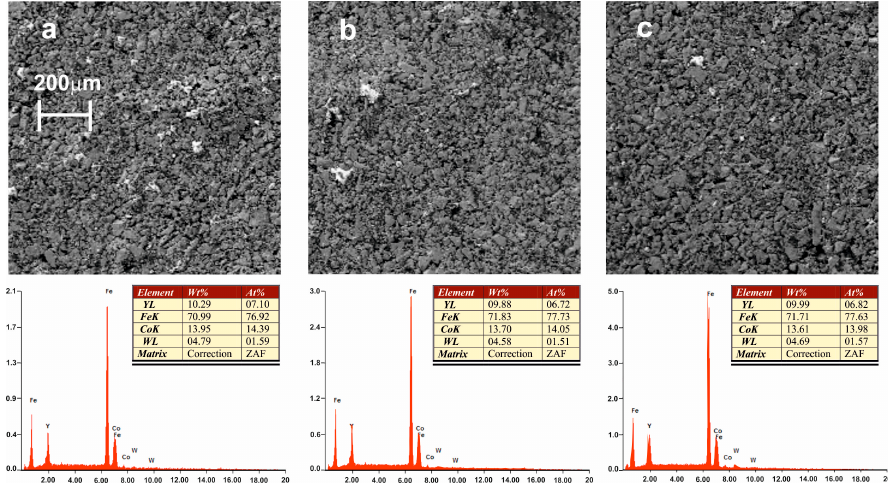
Figure 2. Structure and chemical composition of alloys produced by the suction method: ( a ) Fe 61 Co 10 W 1 Y 8 B 20 , ( b ) Fe 62 Co 9 W 1 Y 8 B 20 , ( c ) Fe 63 Co 8 W 1 Y 8 B 20 .